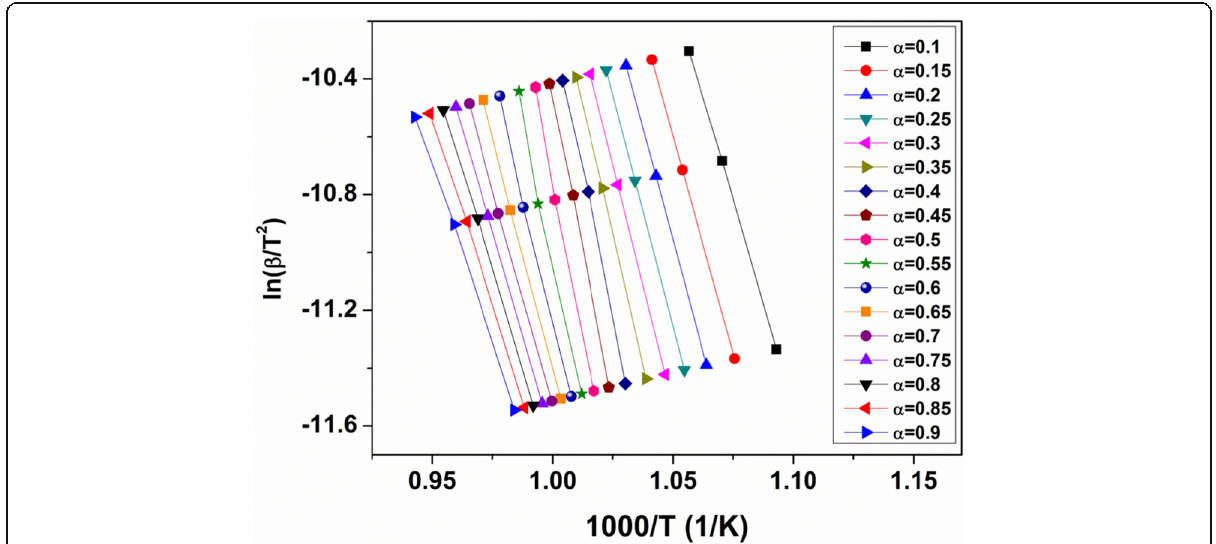
Fig. 6 KAS plot of the solid-state reaction for different values of α